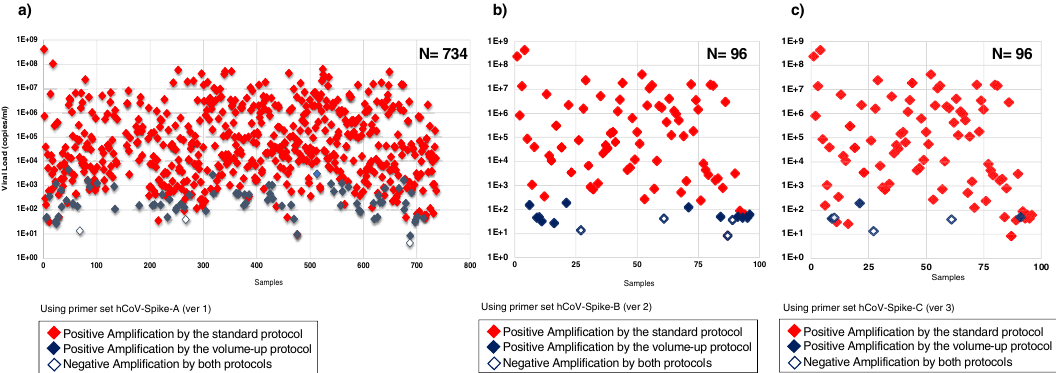
Figure 3. Viral load dependent postivity of nested PCR for spike region using a) primer set version 1, b) primer set version 2 and c) primer set version 3. The first scattered plot in a) showed the positive amplification versus the viral load for the primer set hCoV-Spike-A. The red colored dots represent those positive amplification by the standard protocol, the blue color for positive amplification by the volume-up protocol and the while color with blue marginated dots represent for the negative amplification by both protocols. The scattered plot in b) and c) showed for the primer set hCoV-Spike-B and hCoV-Spike-C respectively.